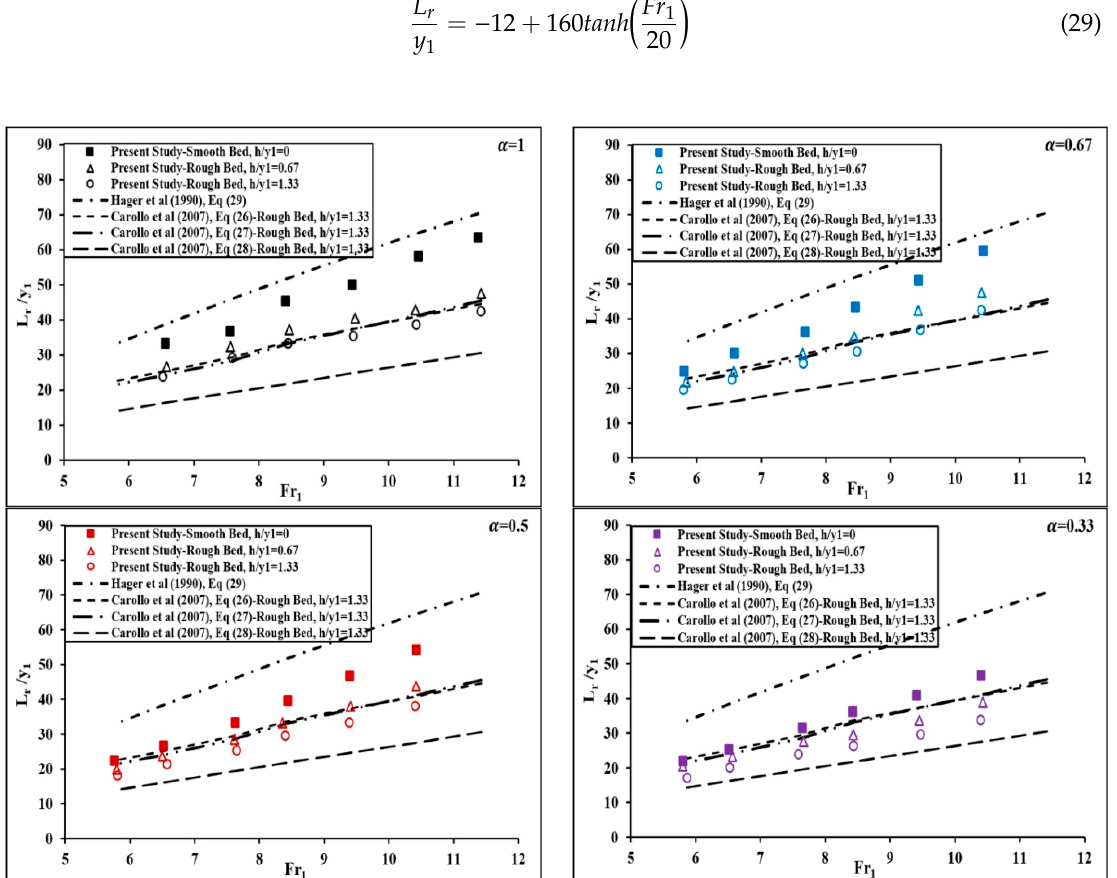
Figure 13. Relative roller length of the hydraulic jump as a function of upstream Froude number for two relative roughness heights ( h / y 1 = 0.67 and 1.33) and di ff erent expansion ratios ( α = 0.33, 0.5, 0.67, 1) with asymmetry ratio of ∆ = 0.16.